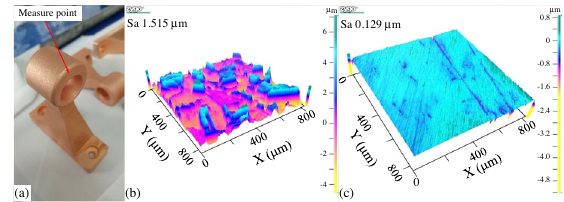
FIG. 2. Over-pickled DT and its surface roughness: (a) pickled DT; (b) surface roughness of pickled DT; (c) surface roughness of DT after surface treatment.